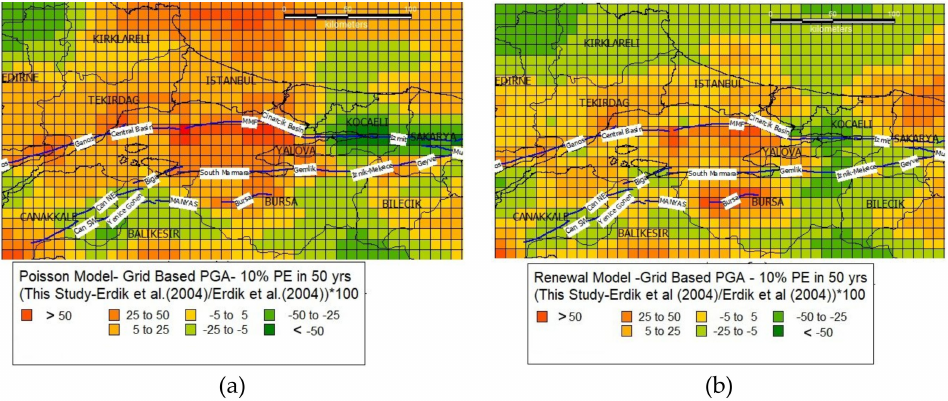
Figure 27. Di ff erence map of the time-independent and time-dependent model results from this study and [9]. It represents the ratio between the mean PGA at {[ PSHA this study − PSHA Erdik et al. [9]] / PSHA this × 100, Erdiketal.[9]andthisstudy(%10in50yrs.). ( a )Poissonmodel( b )renewalmodel, calculated study } using the background seismicity and individual fault segments. In red: positive amplifications. In green: negative